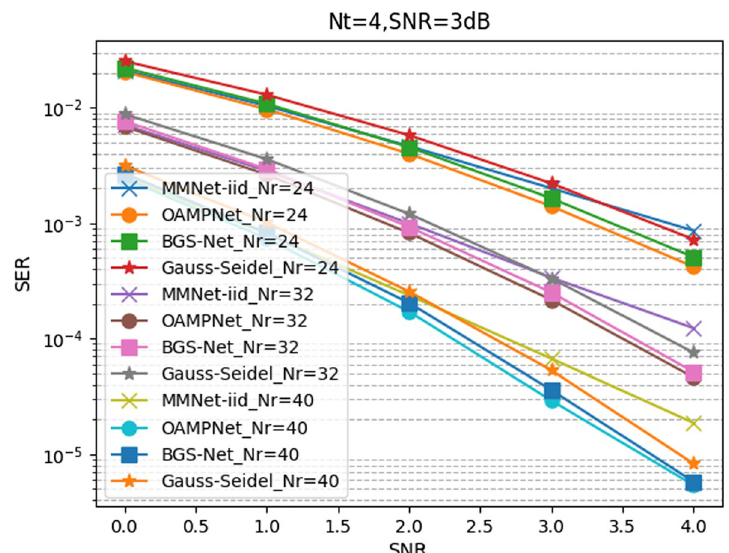
Fig. 11 Effect of the ratio α between the receiving and transmitting antennas on the performance of the algorithm for N t = 4 , SNR 3dB, QPSK, SAUE system =